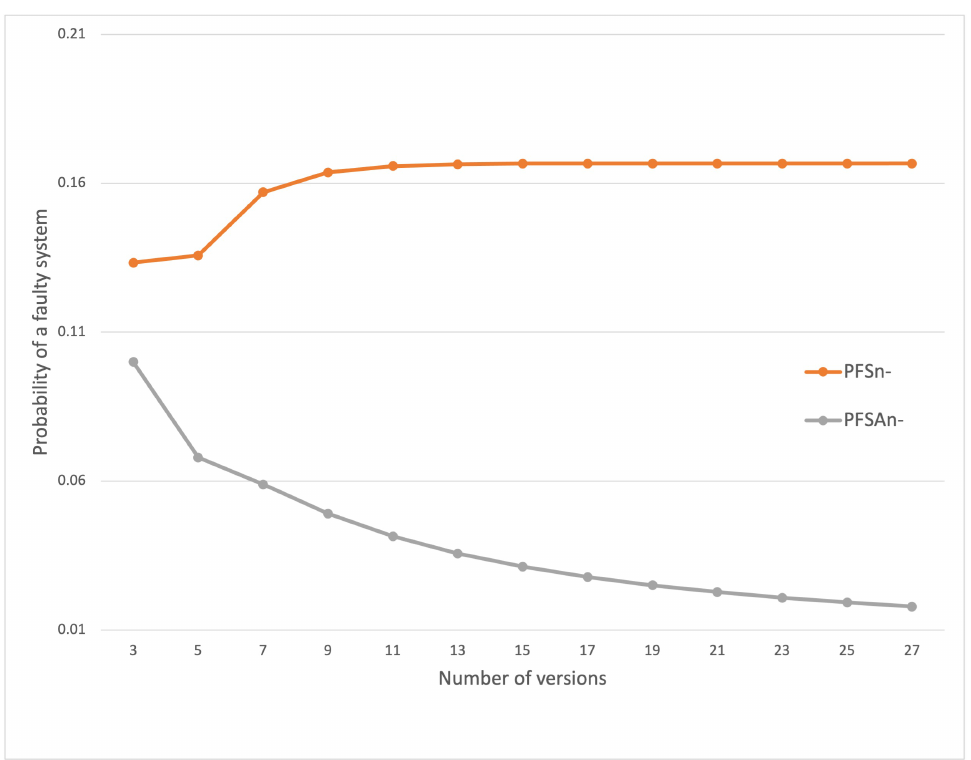
Figure 5. The two studied techniques, PFS n and PFSA n